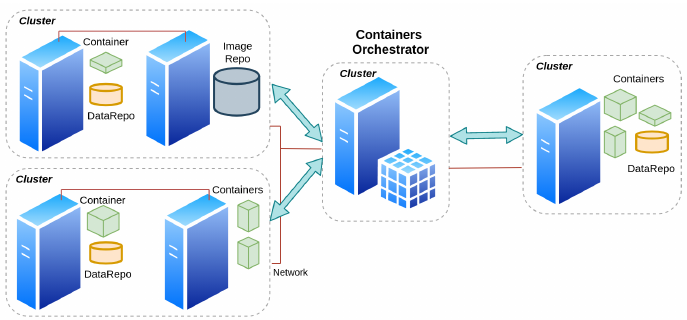
Figure 2. Example of a distributed platform.